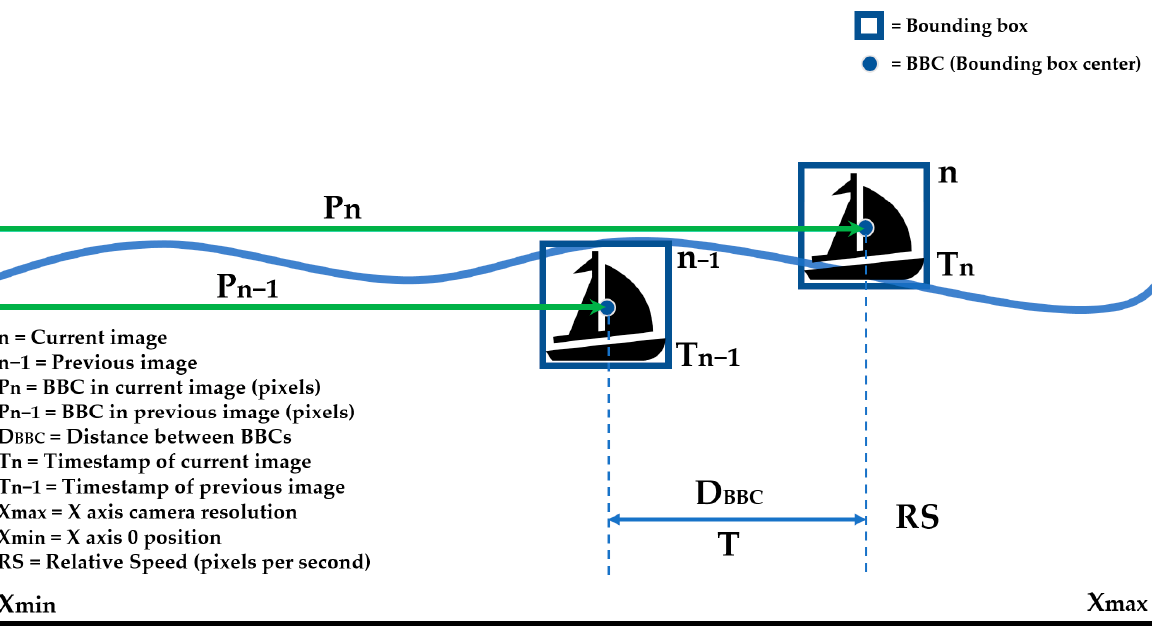
Figure 12. Calculation of acceptable latency limits. Main ASV camera point of view. From each successfully analyzed image, the bounding box of the detected vessel, its relative coordinates in the image, as well as its timestamp are obtained. By knowing the distance between bounding box centers (BBCs) and the time difference between analyses (T), the relative speed (RS) at which the target moves in the image can be obtained. During the time lapse between the analysis of two consecutive images, we approximate the rela ‐ tive speed of displacement of the target vessel and the ASV as a constant value, due to the considerable inertia of vessels at sea. With this information, it is calculated when the target BBC will leave the range of vision, and the SAAO can determine the selection of the pre ‐ ferred or alternative source of AI with regard to latency. Several factors affect SAAO decisions, and they can be measured indirectly through latency and accuracy. Low latency and high accuracy are always desirable results, but every AI cloud or edge platform has its advantages and handicaps, and we cannot always achieve both simultaneously. Balance and effective decision making are the keys to make a mission efficient and successful. 5. Experimental Test and Results 5.1. SAAO Test In order to test the decision making of the SAAO algorithm, an experiment was car ‐ ried out based on the analysis of a 1.5 h video filmed in the Bay of Cartagena. The most interesting results were from a 2 min sequence of a fishing boat, whose results were ana ‐ lyzed as described below. A 10 s extract of the analysis is shown in this experiment. For the experiment, this video was used as the image source for the IoT gateway device, replacing the “Cameras” block shown in Figure 2. The captures extracted by the IPA (image processing algorithm) were analyzed in three different scenarios. First, only an edge computing analysis was carried out, recording latency and accuracy results, with ‐ out the intervention of SAAO. The experiment was then repeated with the same images analyzed using cloud computing. Finally, the SAAO was tested in making decisions on the most suitable AI source for the analysis of the next image, based on the results ob ‐ tained, and for each of the four stages, as shown in Table 4 and Figure 13.